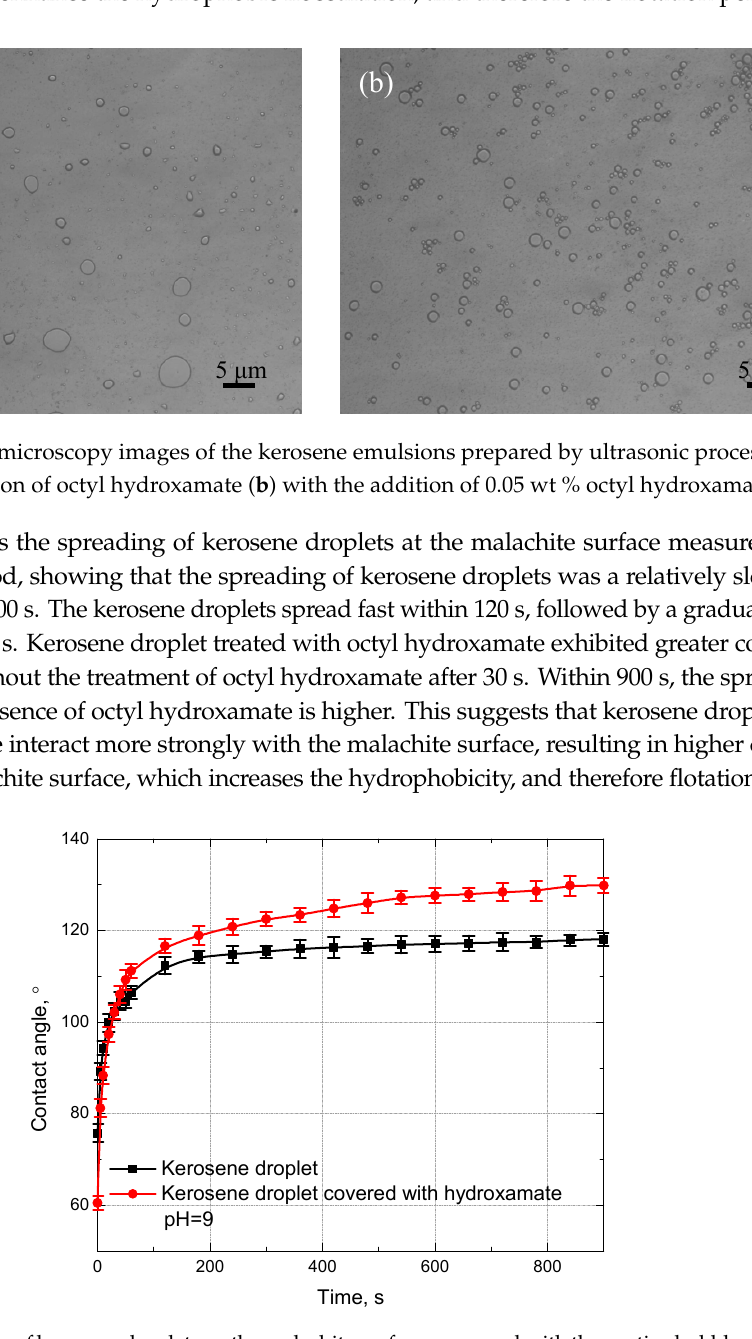
Figure 5. Spreading of kerosene droplets on the malachite surface measured with the captive bubble method.